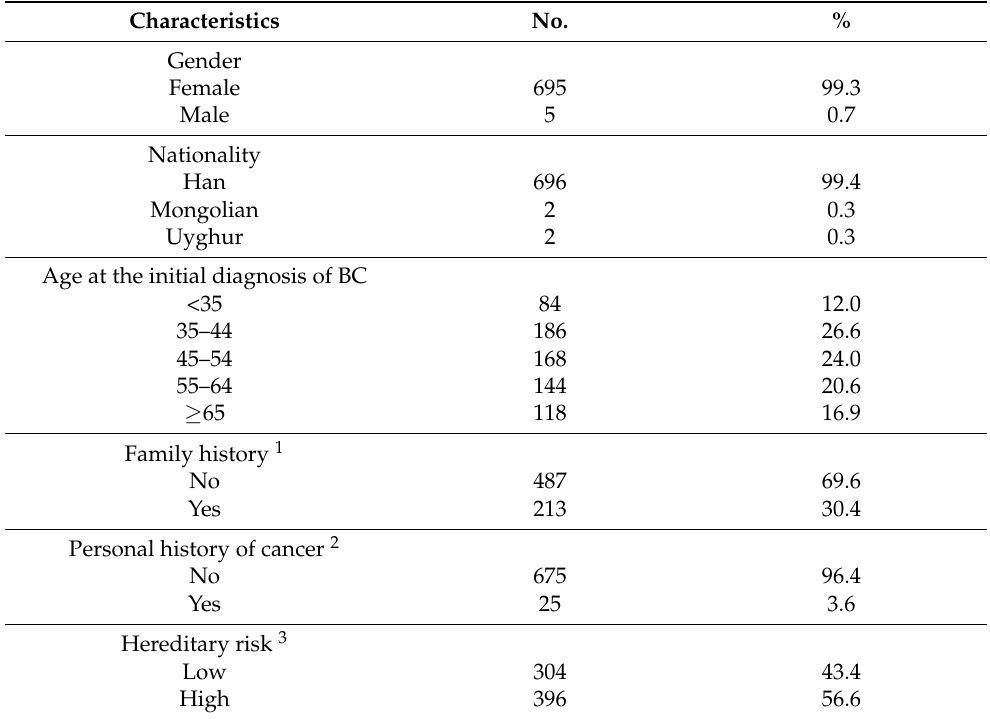
Table 1. Characteristics of 700 patients with BC included in the study.